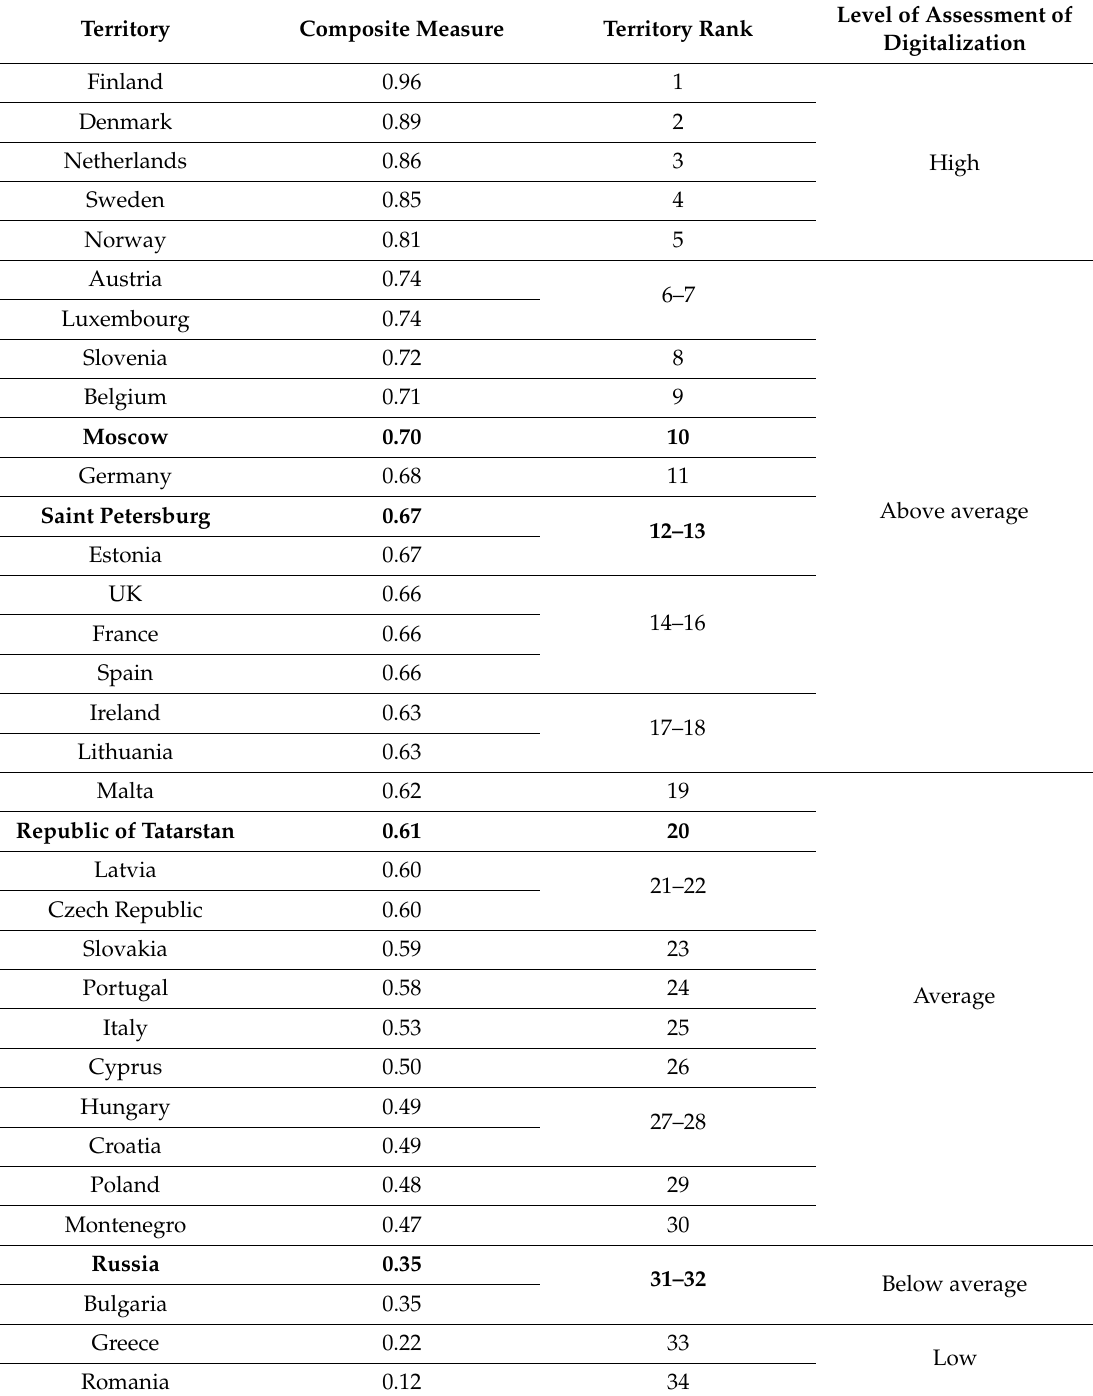
Table 8. Results of assessment of digitalization levels in European countries and top federal subjects of Russia in 2017